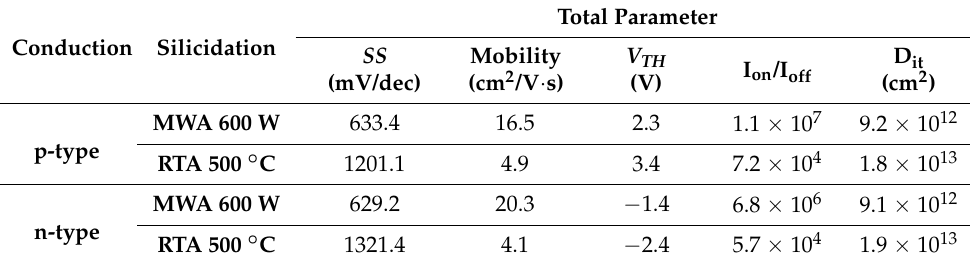
Table 2. The electrical parameters of the 600-W MWA and 500- ◦ C RTA NiSi x SB-TFTs, including the subthreshold swing ( SS ), field-effect mobility ( µ FE ), threshold voltage ( V TH ), on/off current ratio (I on /I off ), and interface state density (D it ). Total Parameter Conduction Silicidation SS